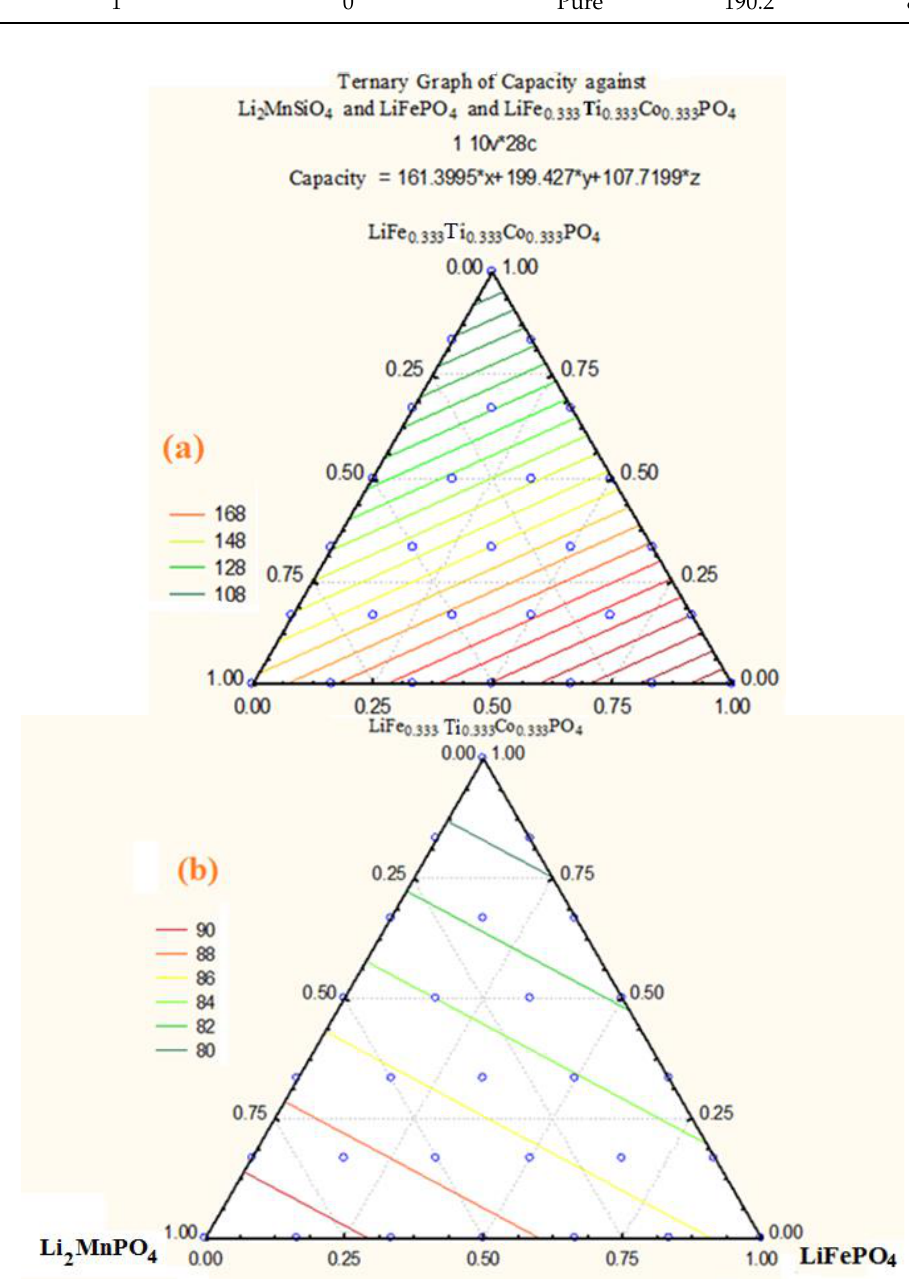
Figure 6. ( a ) Ternary of capacity versus (1-x-y) LiFe 1/3 Ti 1/3 Co 1/3 PO 4 xLi 2 MnPO 4 and yLiFePO 4 system composites; ( b ) Ternary of cyclability versus (1-x-y) LiFe 1/3 Ti 1/3 Co 1/3 PO 4 xLi 2 MnPO 4 and yLiFePO 4 system composites.